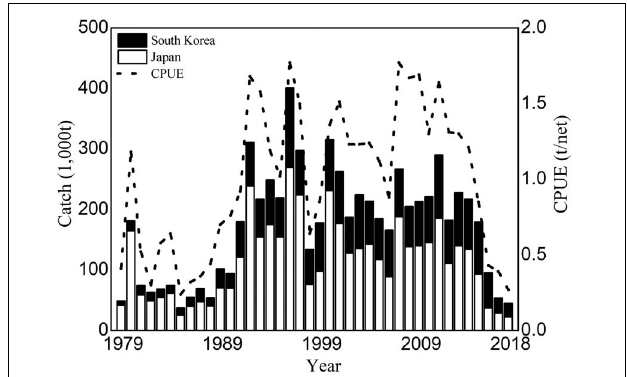
FIGURE 1 | Annual catch and CPUE of the Japanese flying squid winter cohort for each country from 1979 to 2018